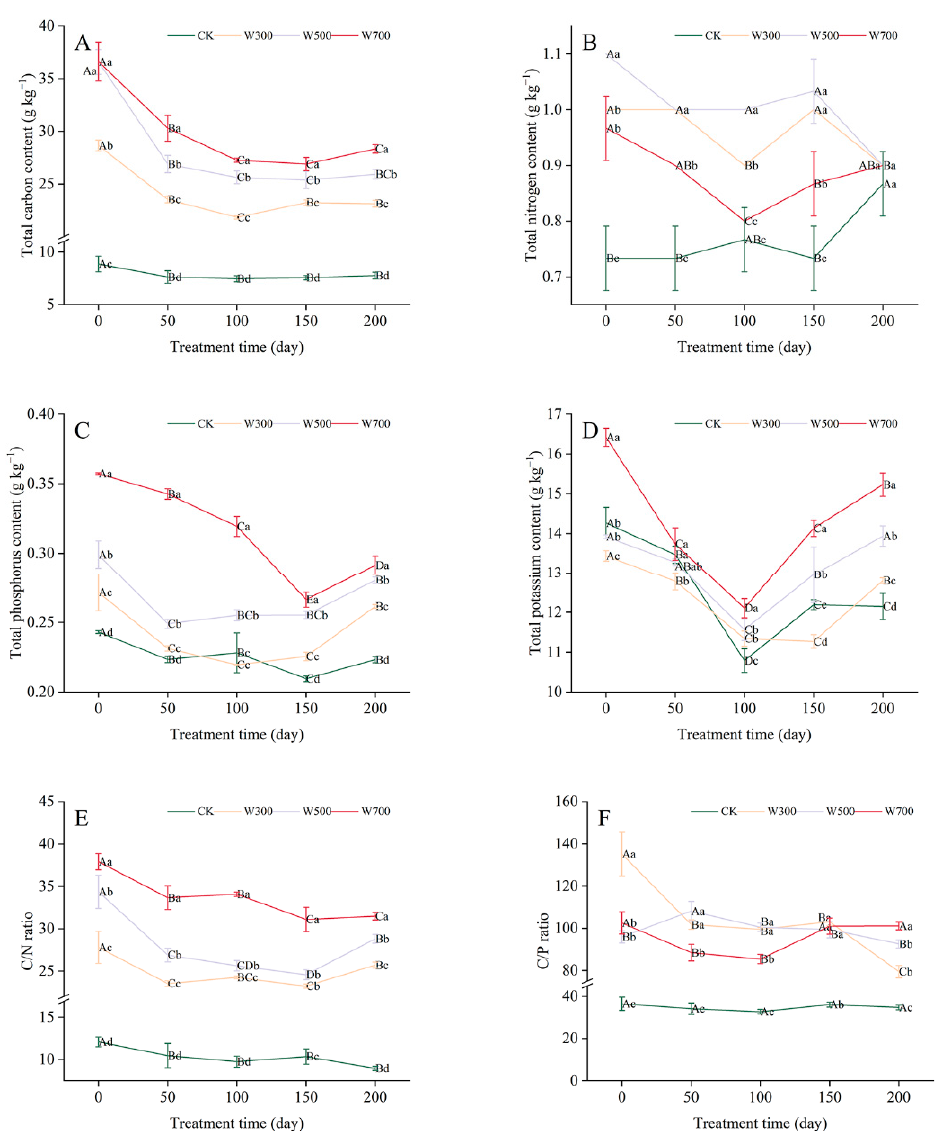
Figure 3. Effects of biochar pyrolyzed at different temperatures on soil total contents of carbon ( A ), nitrogen ( B ), phosphorus ( C ), and potassium ( D ), as well as the ratios C/N ( E ), and C/P ( F ) at 0, 50, 100, 150 and 200 days after treatment. CK: without biochar; W300: with biochar pyrolyzed at 300 °C; W500: with biochar pyrolyzed at 500 °C; W700: with biochar pyrolyzed at 700 °C. Different uppercase letters indicate significant differences among the different sampling times in the same treatment, while different lowercase letters indicate significant differences among different treatments at the same sampling time according to Duncan’s test ( p < 0.05),